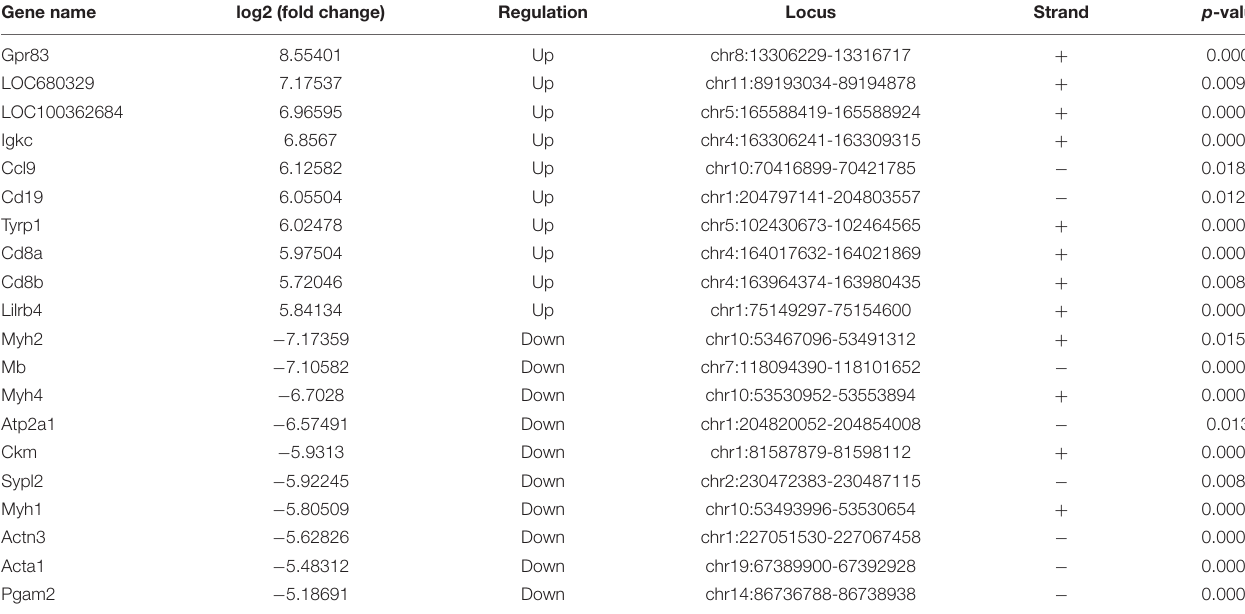
TABLE 3 | The top 20 differently expressed mRNAs in SNI based on log2 (fold